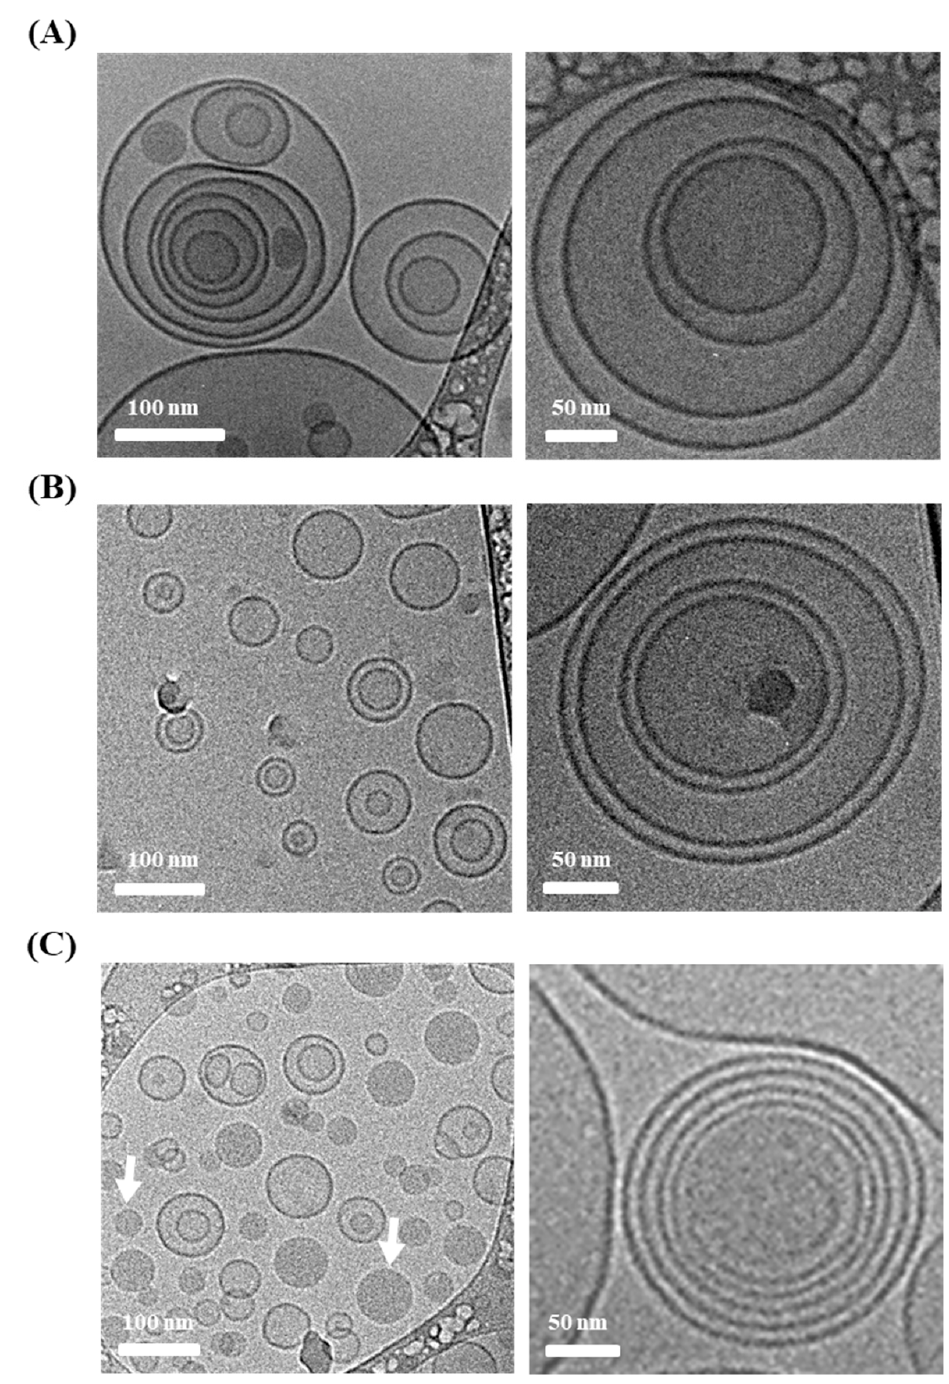
Figure 2. Representative cryo-TEM images of lipo-oil-somes (LOSs) prepared with different edge activators; ( A ) cholesterol (L1), ( B ) sodium deoxycholate (L2), and ( C ) polysorbate 80 (L3). White arrows in ( C ) indicate oil-in-water emulsion droplets.